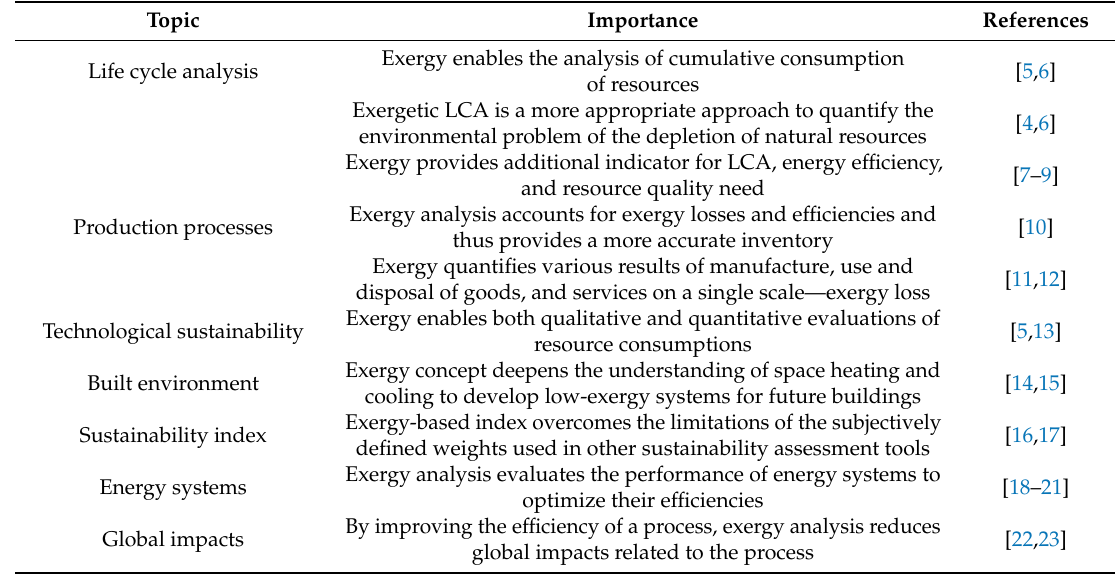
Table 1. Summary of the importance of exergy classified by topic